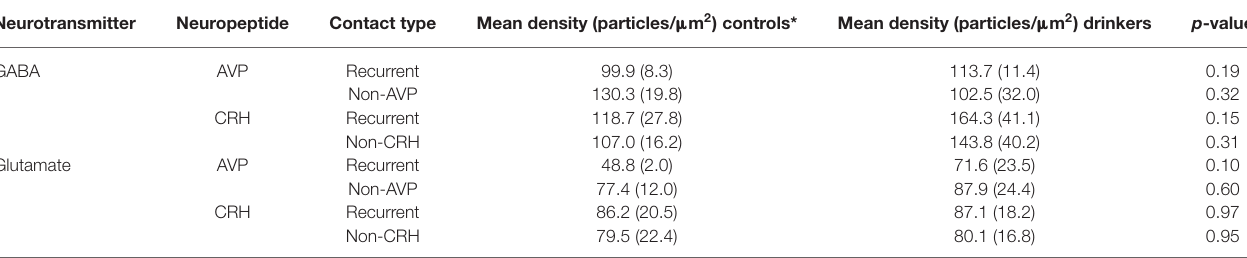
TABLE 2 | Mean ( ± SD) GABA and glutamate density in control ( n = 3) and ethanol-drinking monkeys ( n = 5).